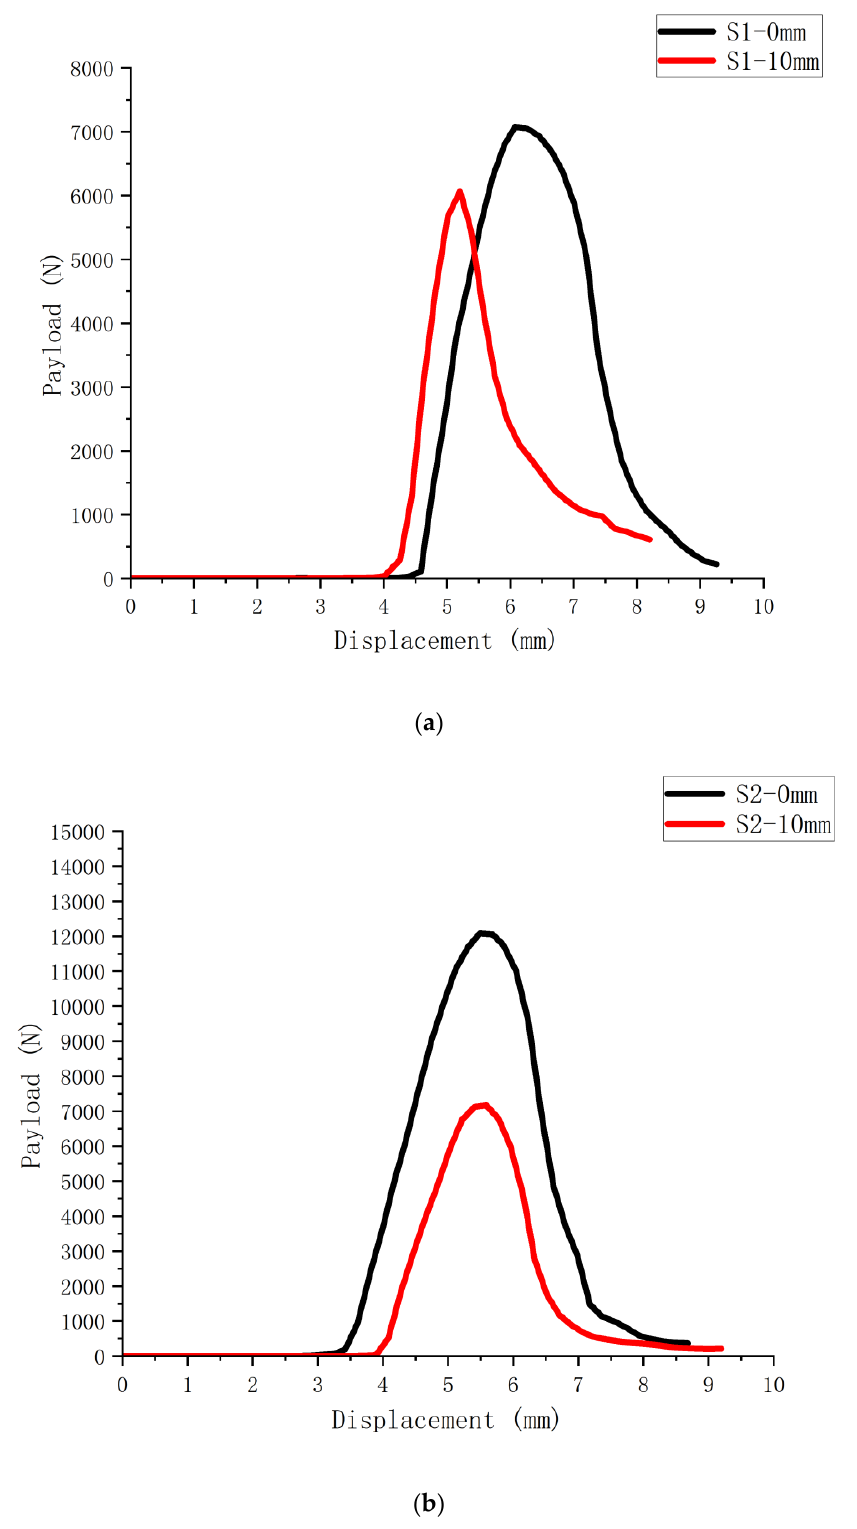
Figure 2. Load-displacement curves of unaged asphalt mixture SCB specimens: ( a ) S1 asphalt mixture SCB test curve; ( b ) S2 asphalt mixture SCB test curve.